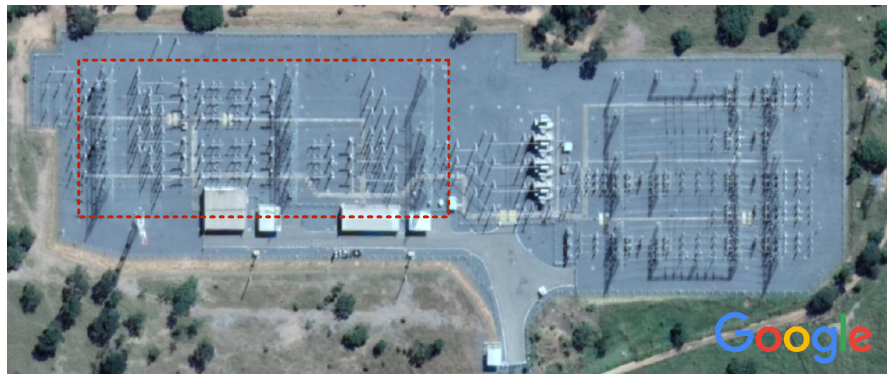
Figure 9. Top view of the EPS photographed by Google Earth satellite in 2021